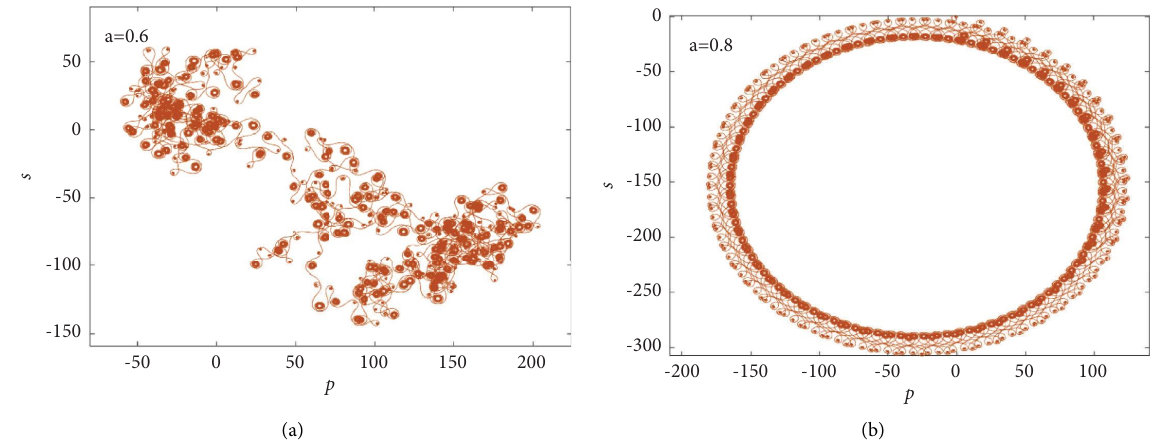
Figure 8: p − s plane trajectory of the system. (a) a � 0 . 6; (b) a � 0 .